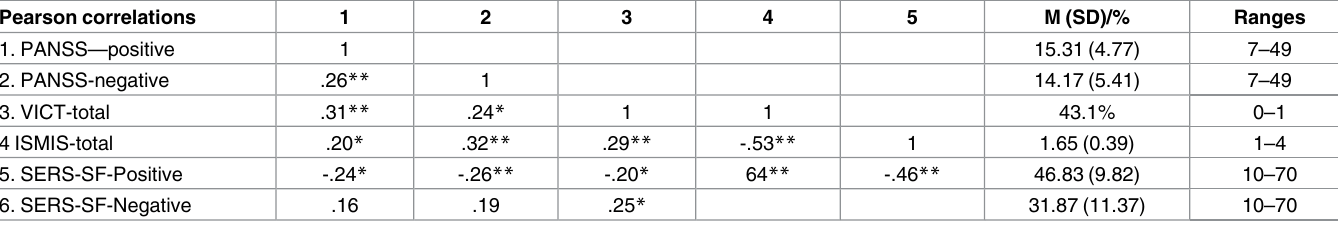
Table 1. Correlation coefficients and descriptive statistics of variables included in the SEM (n = 102).